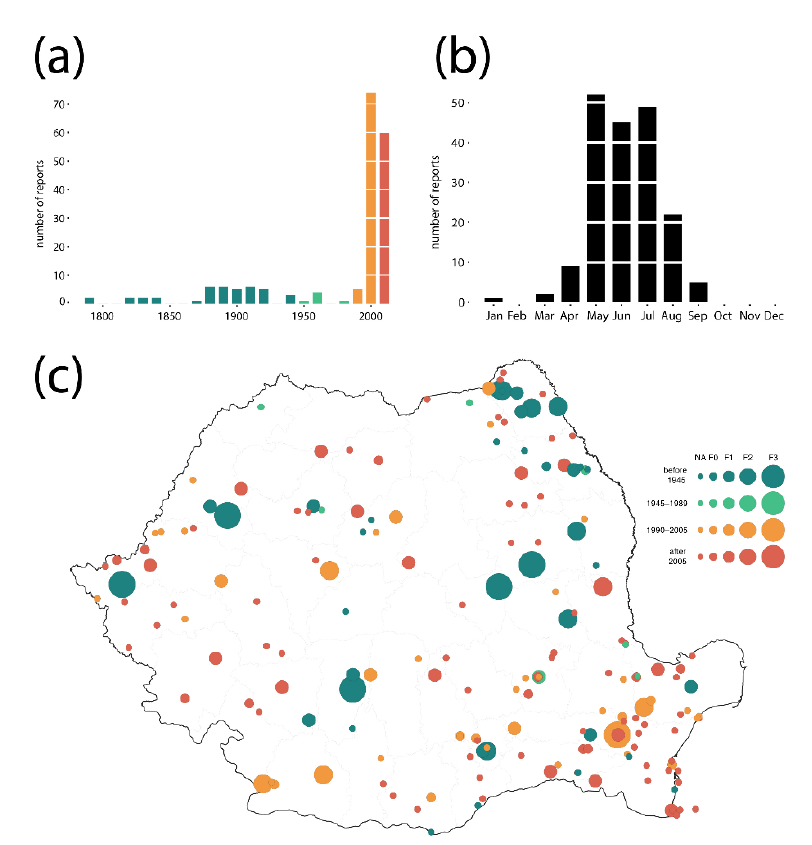
Figure 4. Annual distribution of tornado reports between 1634 and 2019 ( a ), monthly distribution of tornado reports ( b ), and spatial distribution of tornadoes in Romania during 1634 and 2019 ( c ); the colors in ( a and c ) attribute the events to different historical epochs: before 1945 ( dark green ), 1945–1989 ( light green ), 1990–2005 ( orange ) and after 2005 ( dark orange ). The tornado intensity is given by the circle’s size.